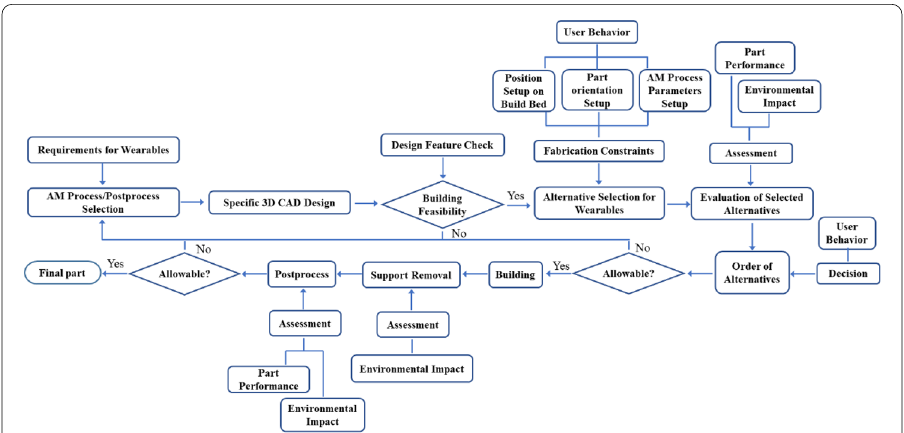
Fig. 2 Logistics practice for the AM process, in consideration of performance and user behavior for AM wearables